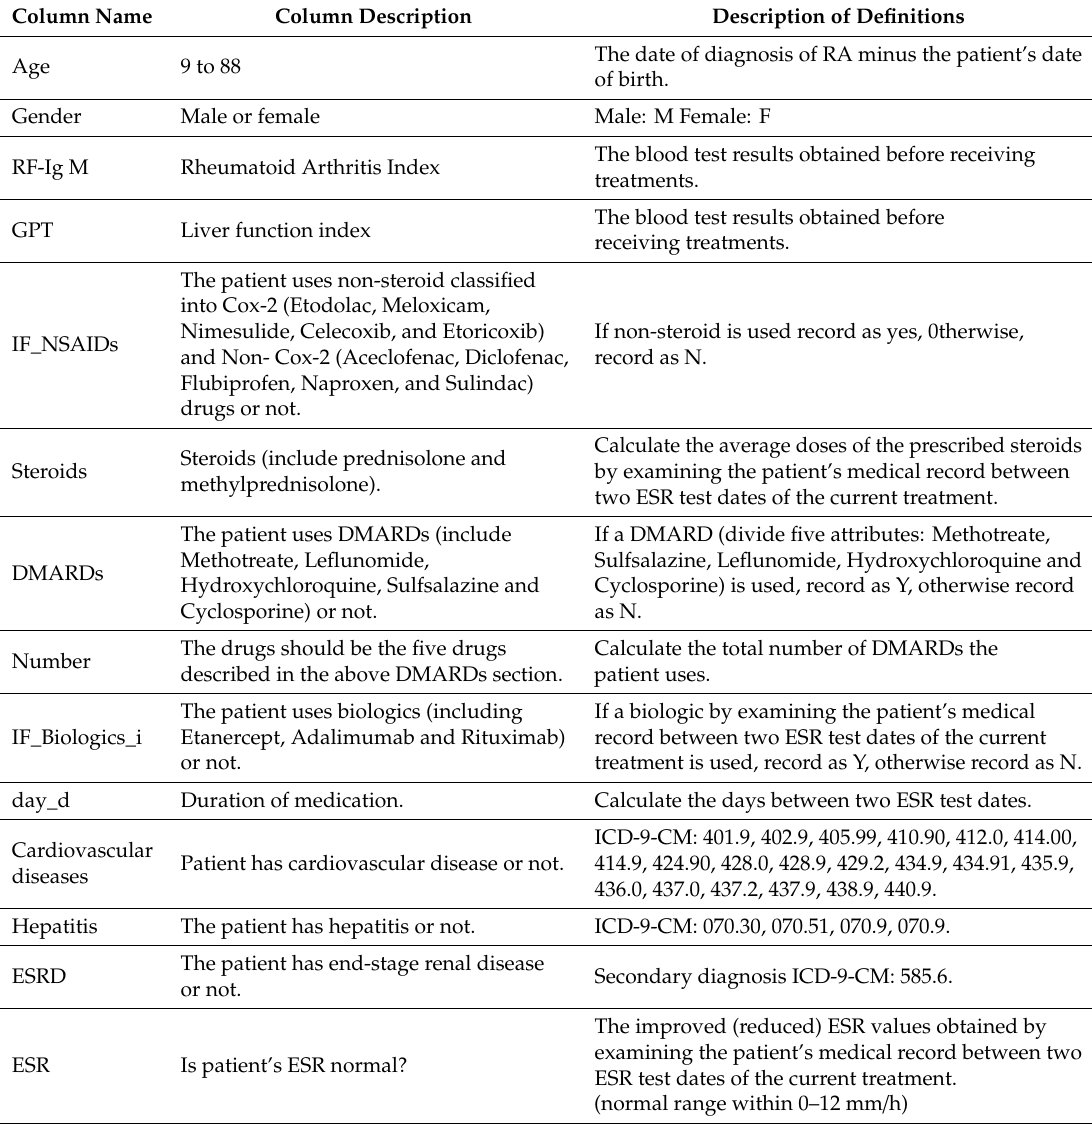
Table 1. Definitions of the variables used in this